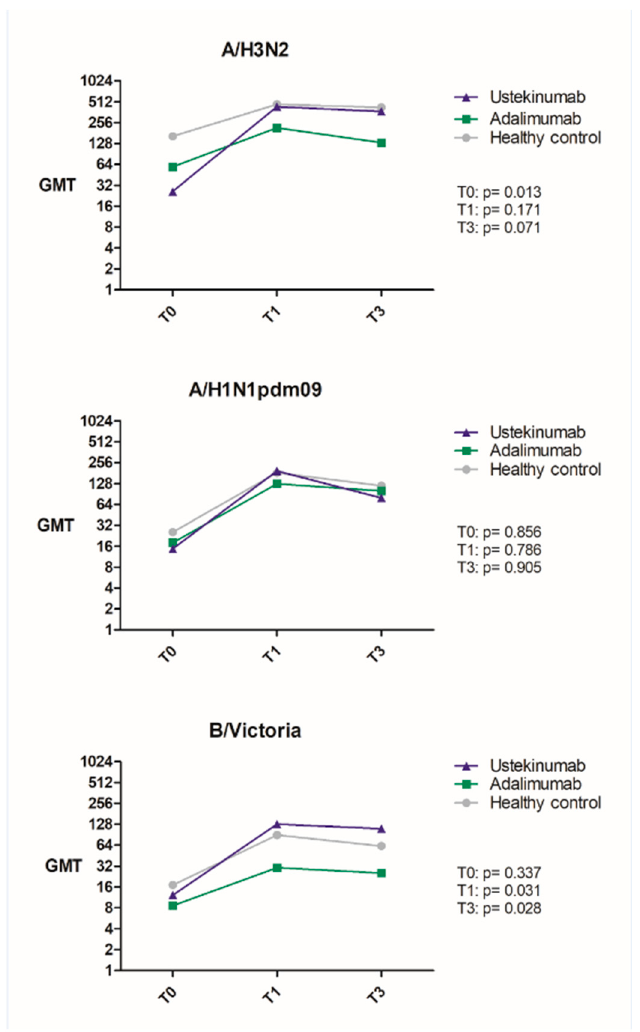
Figure 2. Dynamics of geometric mean HI titers (GMT) to influenza A / H3N2, A / H1N1pdm09, and B / Victoria vaccination according to study groups. T0 = pre-vaccination, T1 = one-month post-vaccination, T3 = three months post-vaccination. Comparisons between groups were tested using Kruskal–Wallis tests. A p -value < 0.05 indicates statistical significance.